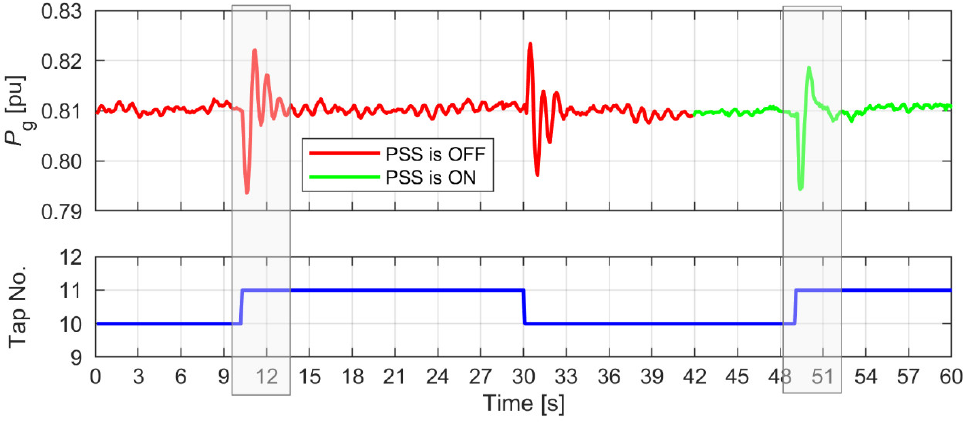
Figure 10. Changing the tap of the step-up transformer [40].